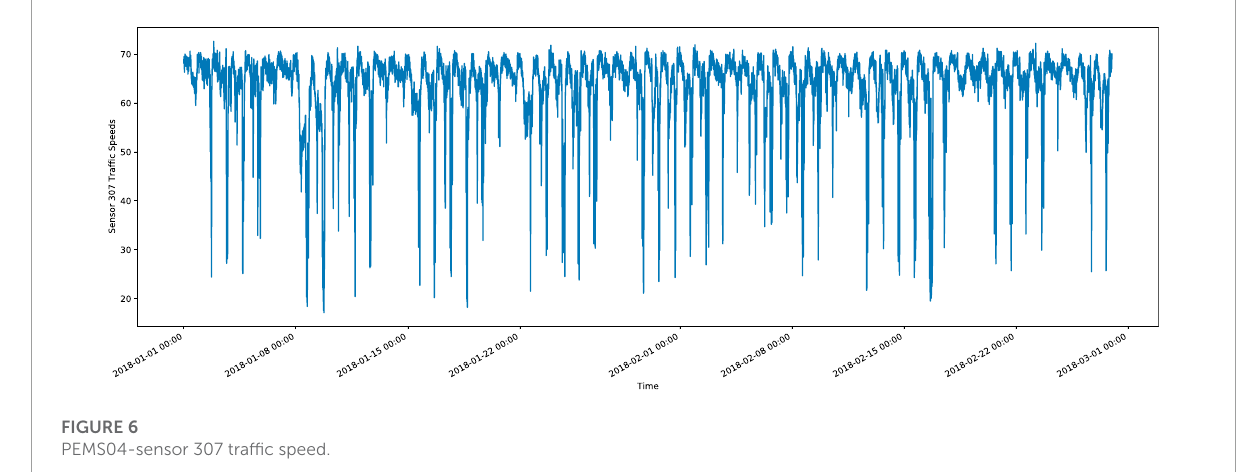
FIGURE 6 PEMS04-sensor 307 traffic speed.